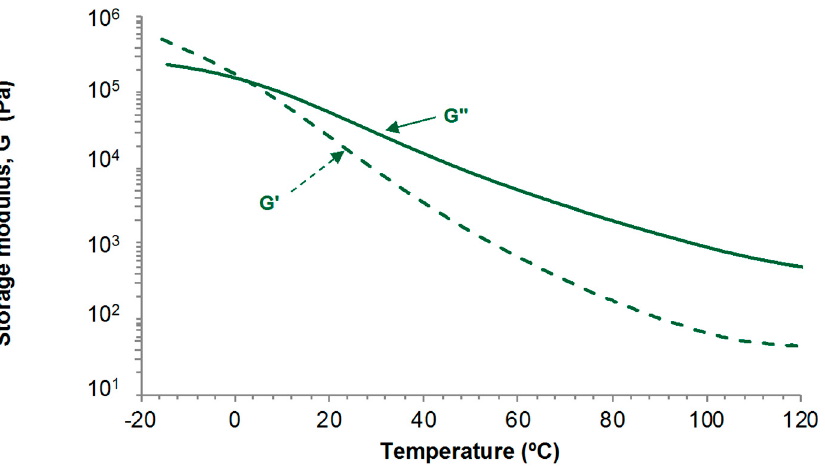
Figure A3. Variation of the derivative of the weight loss as a function of the temperature for the TPUs.